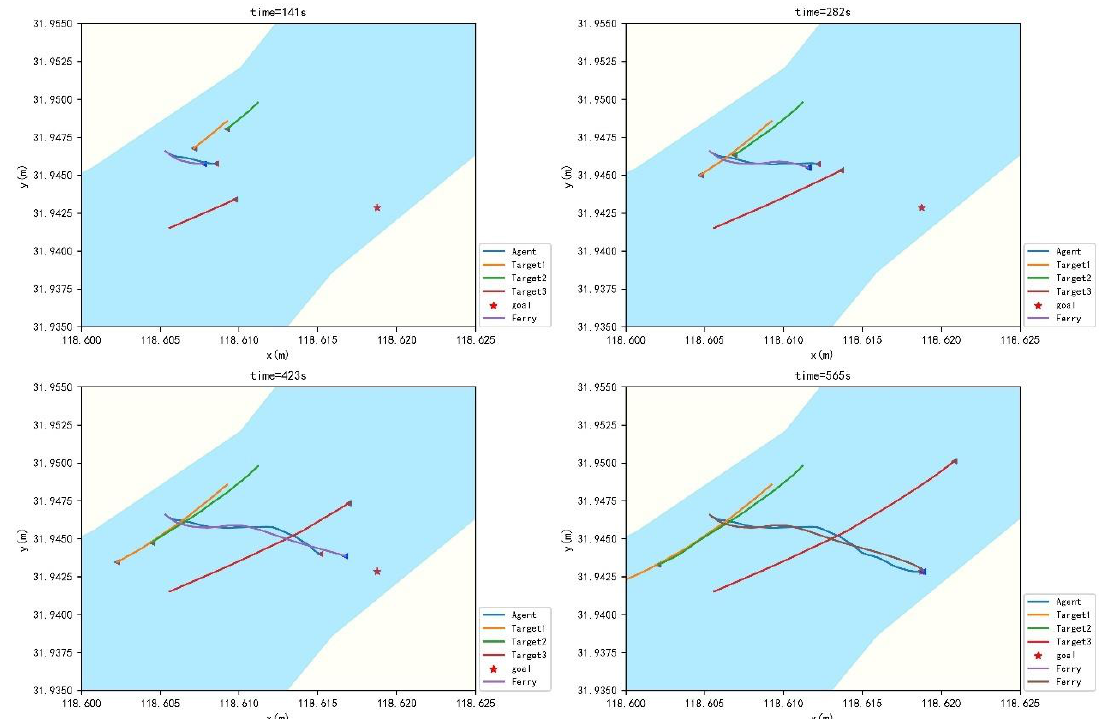
Figure 12. Trained and actual trajectories.